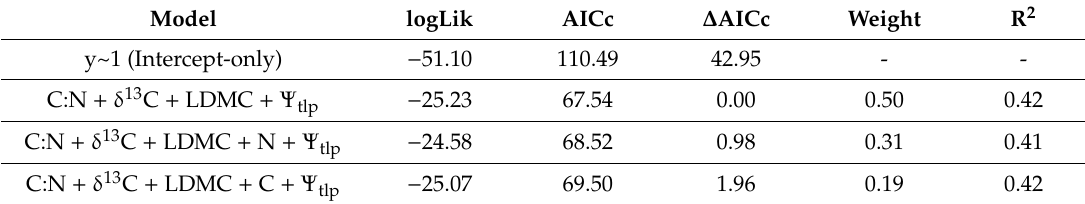
Table 3. Multi-model inference from Linear Mixed Models (LMMs) I norm (response variable) as a function of the Community-Weighted Means (CWMs) of the native assemblage and site as a random factor. Model selection was based on values of the Akaike Information Criterion corrected for small sampling sizes (AICc) across models with all possible factor combinations. Please note that only the models with ∆ AICc ≤ 2 were reported along with their R 2 statistics. Model logLik AICc ∆ AICc Weight R 2 y~1 (Intercept-only) − 51.10 110.49